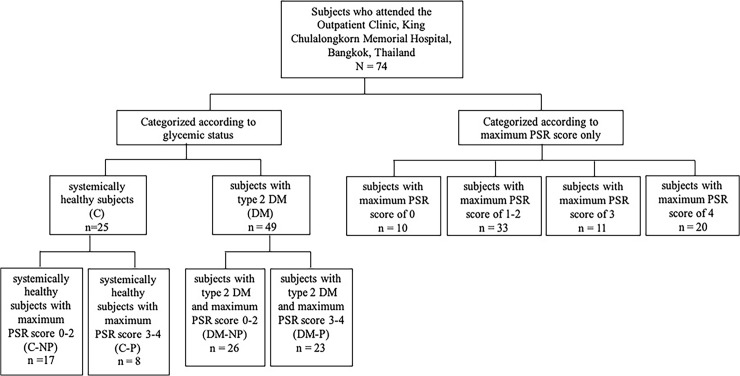
Study flowchart for subject recruitment and categorizations.